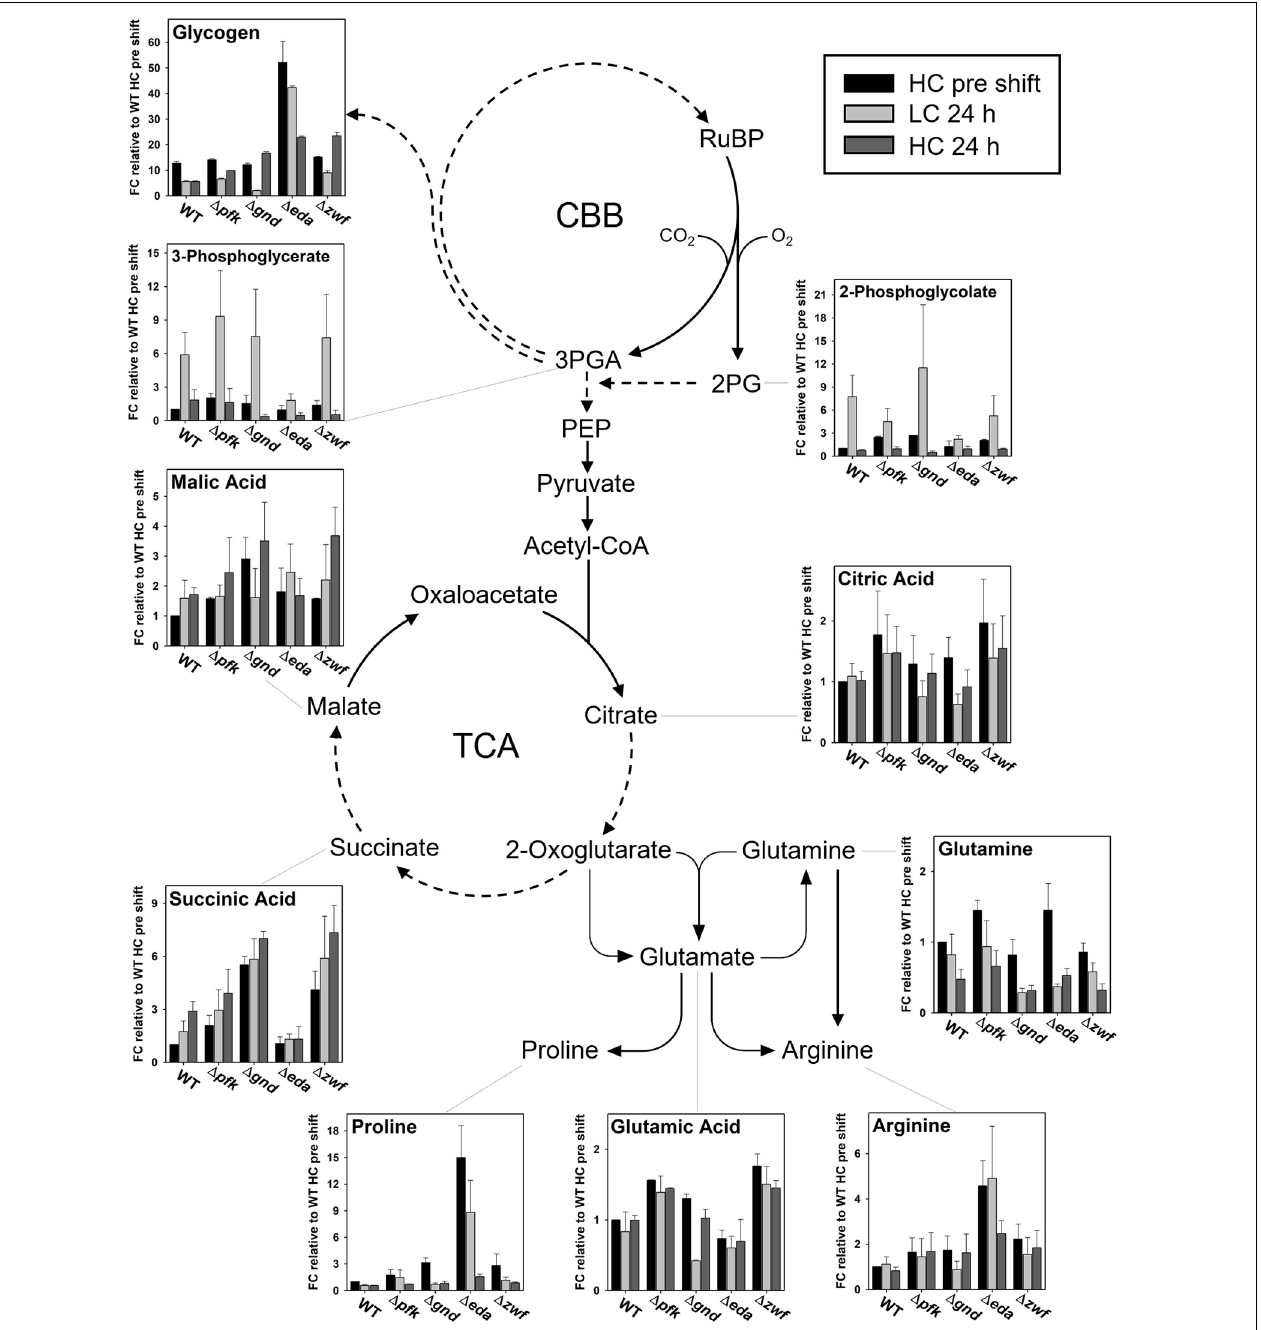
FIGURE 9 | Steady states of selected metabolites in the context of entire metabolism. Dashed arrows indicate that more than one enzymatic reaction is required to catalyze this step. (FC – fold